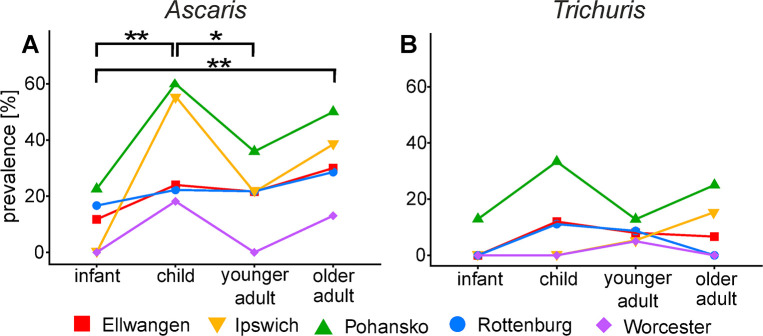
The prevalence of nematode infections in different age groups.The prevalence of Ascaris (A) and Trichuris (B) in different age groups at five medieval sites. Infant 0–5 years, Child 6–18 years, Younger Adult 19–40 years, Older adult 40+years. Each site is depicted with different symbols and colours according to the key. Significant differences in the overall rates of infection are indicated by horizontal bars * p<0.05, ** p<0.005.